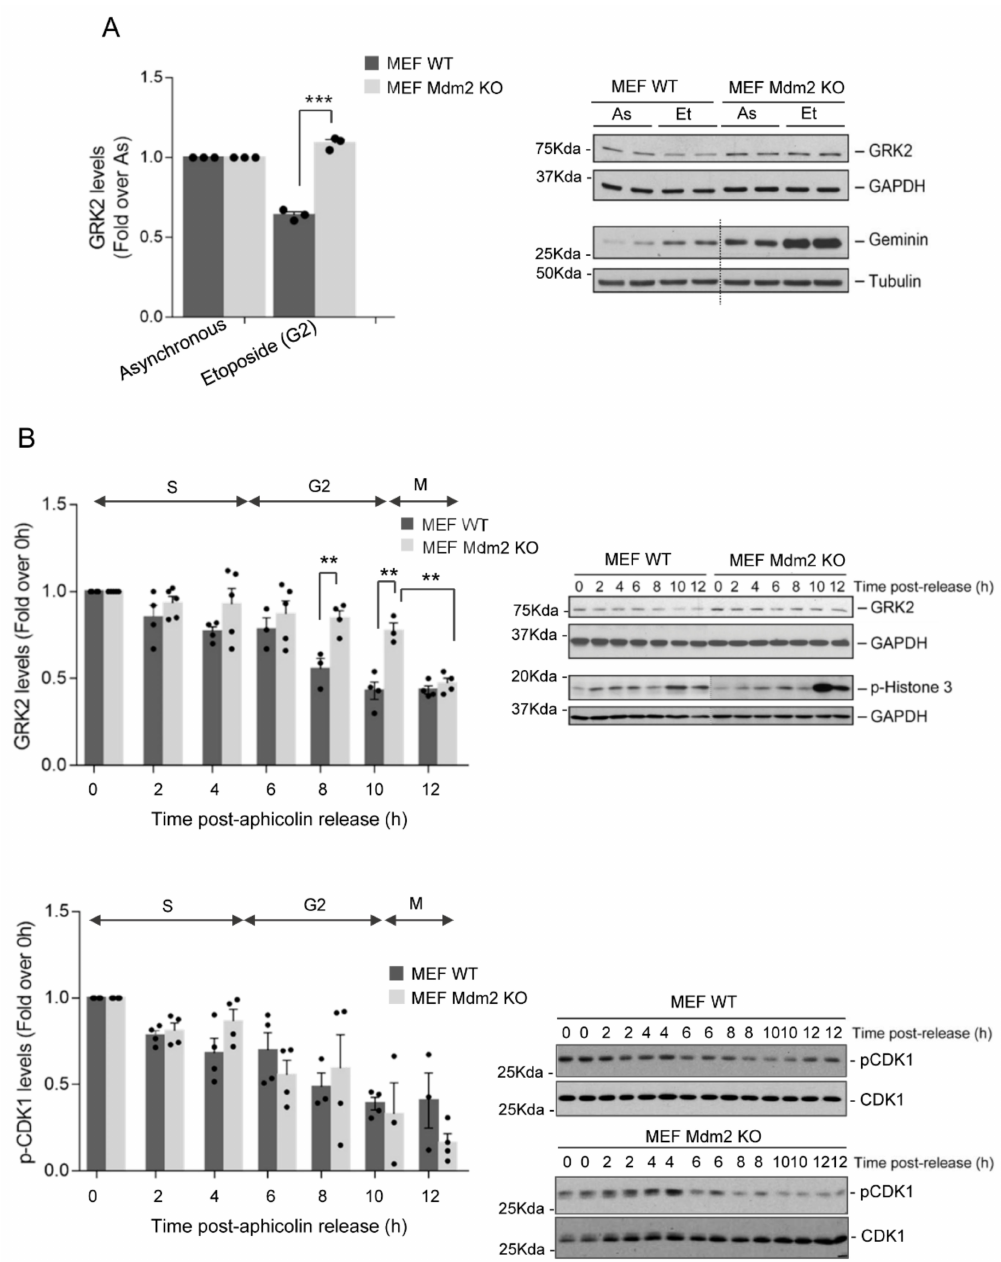
Figure 1. Protein decay of GRK2 in the G2 phase of the cell cycle depends on Mdm2. ( A ) Down-modulation of endogenous GRK2 in the G2 is abrogated in cells lacking Mdm2. Wild-type (WT) and Mdm2-null (KO) mouse embryo fibroblasts (MEF) cells were maintained in exponentially growing conditions (asynchronous, As) or synchronized in the G2 phase by treatment with 5 µ M etoposide (Et) for 18 h. GRK2 levels in RIPA buffer cell lysates were analyzed by immunoblotting and normalized with tubulin as a loading control. Geminin accumulation in the G2 was used as a synchronization marker. Dotted lines indicate cropped lanes from the same blot. ( B ) Both WT and Mdm2-KO MEF cells were arrested in G1/S transition with a thymidine-aphidicolin double block as detailed in Methods and released into the cell cycle for the indicated times. Protein levels of GRK2, pSer10-histone 3 as cell cycle marker, and GAPDH as loading control were analyzed with specific antibodies (upper panel). Cell cycle progression through the G2 phase is not affected by the loss of Mdm2 in MEF cells (bottom panel). Activation of CDK1 was monitored as a decrease in the extent of the inhibitory Y15 phosphorylation. Levels of pTyr15-Cdk1 were detected with a specific antibody, and blots were re-probed after stripping with anti-CDK1 antibody. Data are means ± SEM from 3–4 independent experiments. Representative blots are shown. (** p < 0.01, *** p < 0.001, two-tailed t -test). Detailed information about the Western blots can be found in Figure